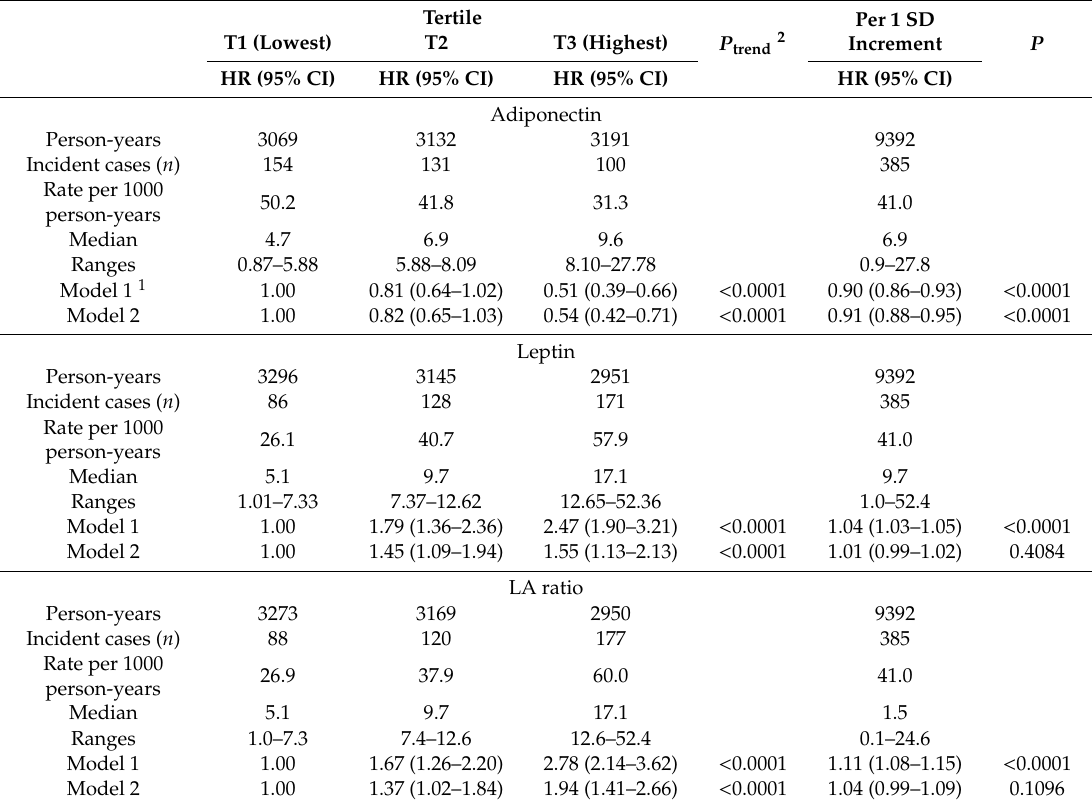
Table 3. Adjusted hazard ratios (with 95% confidence intervals) for metabolic syndrome according to baseline serum adiponectin, leptin levels, and leptin-adiponectin ratio in Korean women aged 45–76